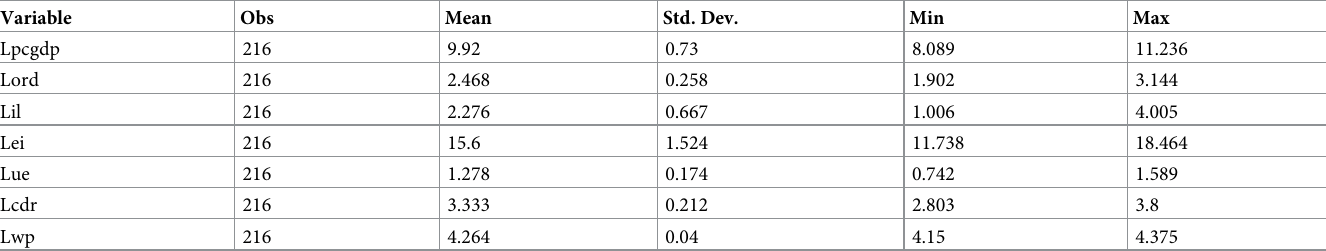
Table 5. Descriptive statistics of western region of China.